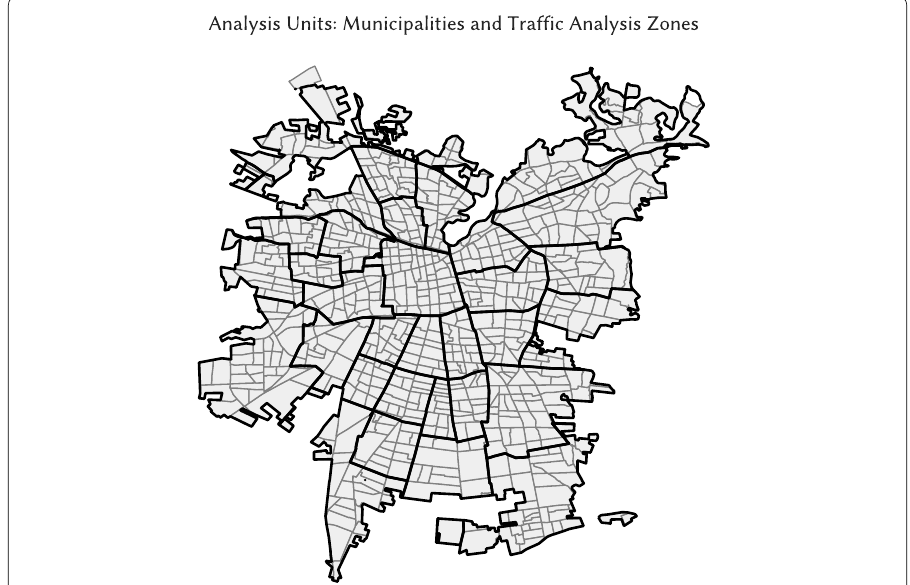
Figure 5 Municipalities in the urban area of Santiago, Chile (black border), and Traffic Analysis Zones under study (grey border), used to assign home and work locations to commuters